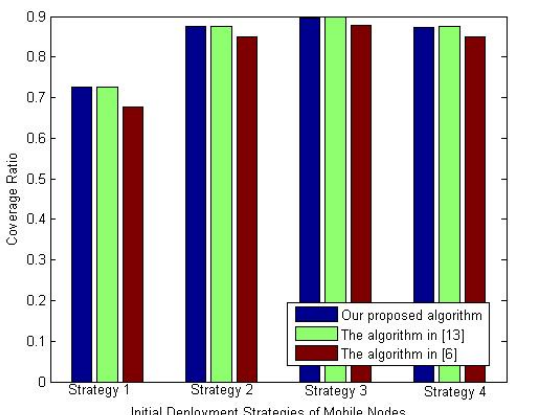
Figure 13. Influence of initial deployment strategy of mobile nodes on coverage ratio.